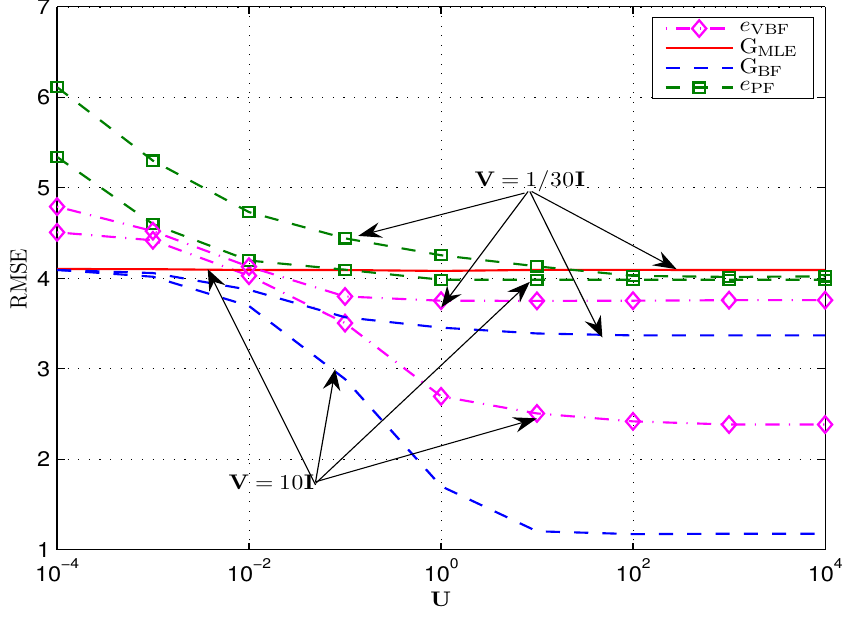
Figure 5. Achieved RMSEs by the VBF and particle filtering (PF) algorithm with different target mobilities. The y -axis is in